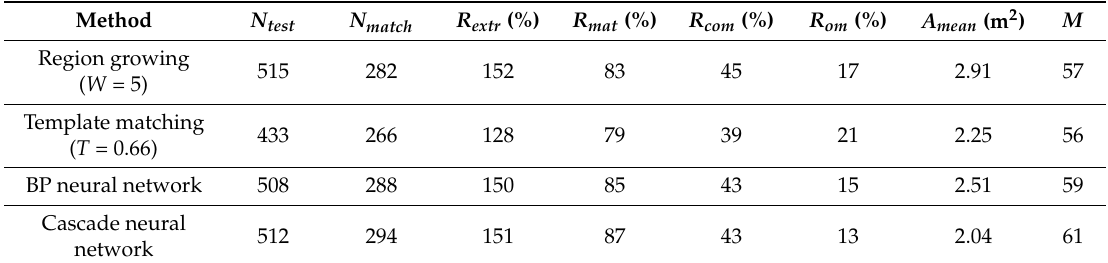
Table 5. Detection results for test area